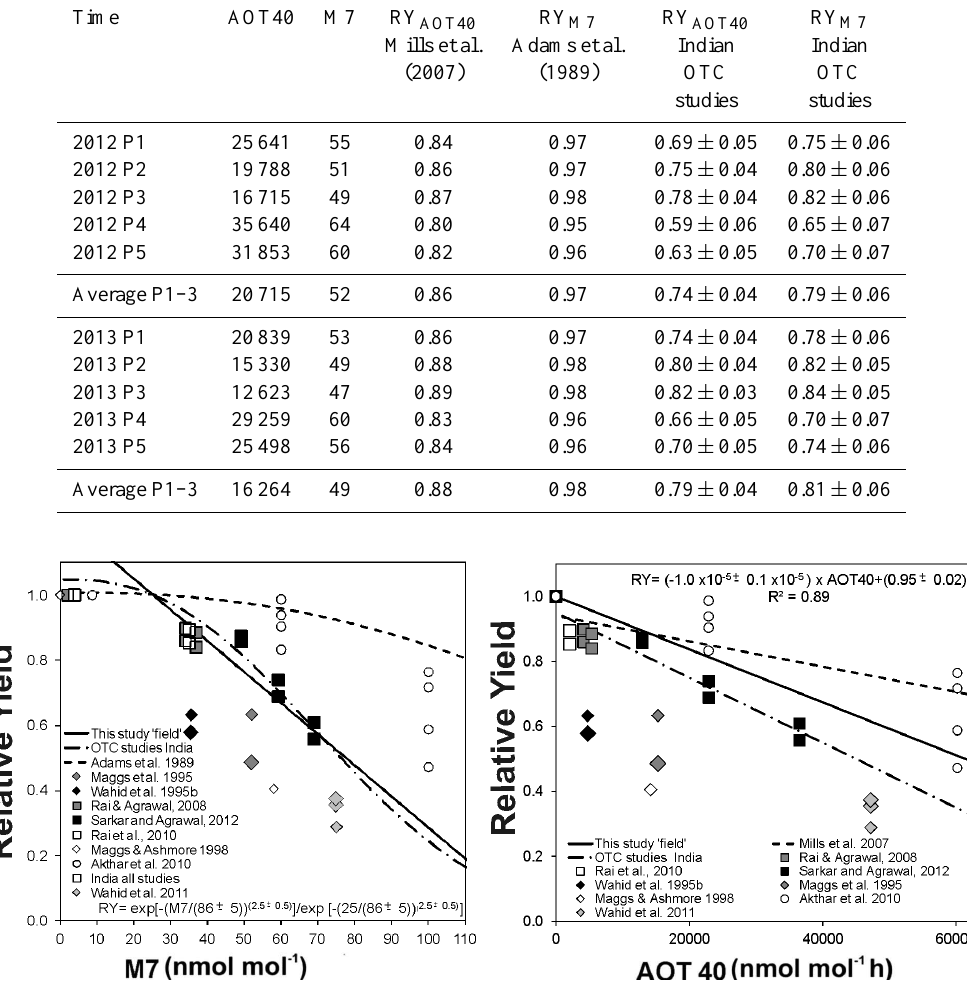
Figure 4. Comparison of the empirical exposure–response relationship based on field data (solid line) with OTC studies conducted in India (squares with dash and dot fit) and Pakistan (diamonds, not included in line fit). Large diamonds indicate studies conducted on basmati; all other studies were conducted on paddy. Circles show plant chamber studies on Bangladeshi rice cultivars conducted in Japan, and the dashed line delineates the European (AOT40; Mills et al., 2007) and American (M7; Adams et al., 1989) dose–response relationship. In all studies presented in this figure, rice plants were exposed to elevated ozone from the date of transplantation until